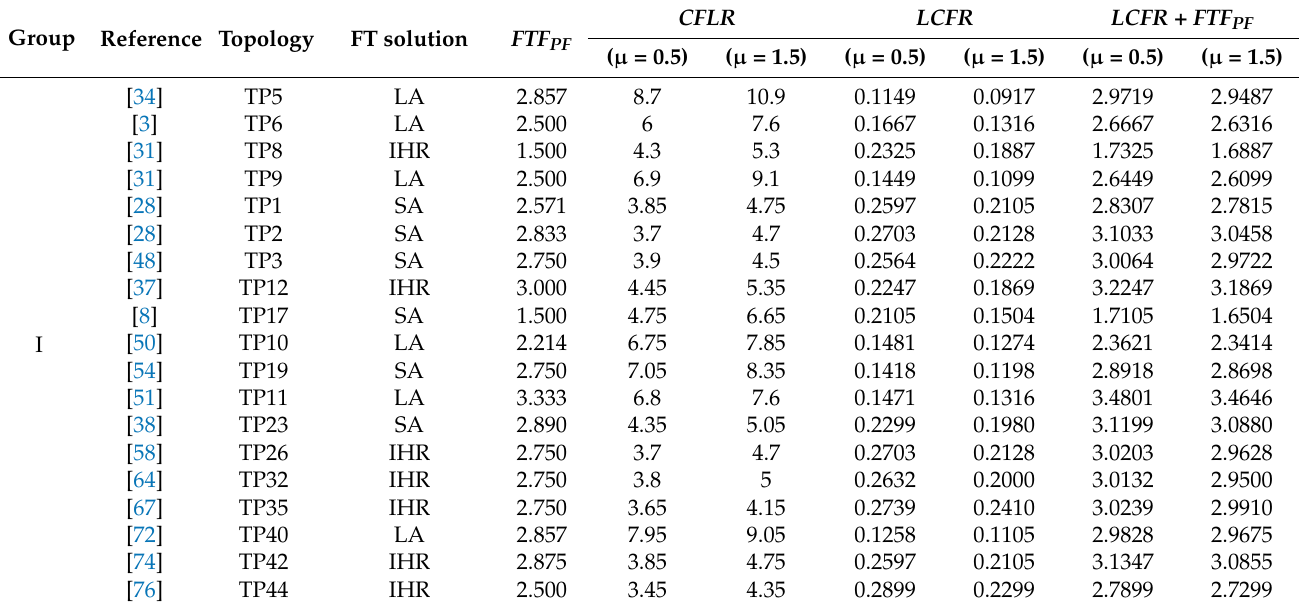
Table 6. Comparison of single-phase five-level FT MLIs for SSOC faults ( TSV is